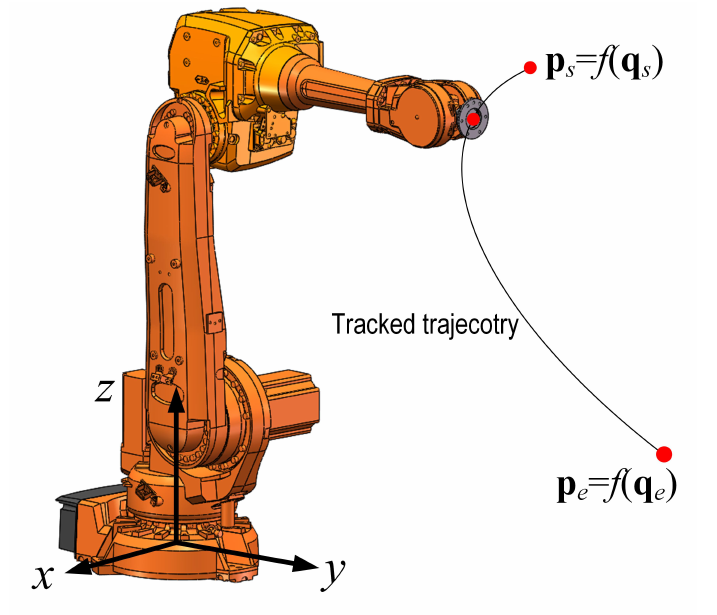
Figure 1. Tracked spatial trajectory of a robot end-effector from the starting position p s to the ending position p e (the original robot CAD model of IRB 4600 was downloaded from the official ABB